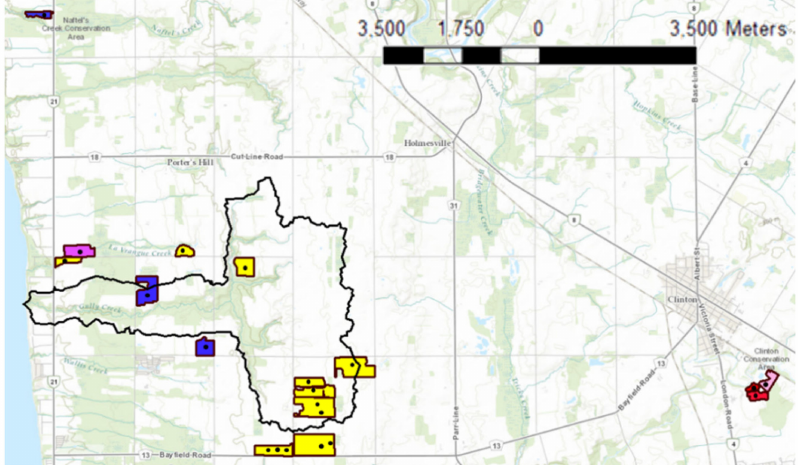
Figure 3. The locations of soil sampling points on the soil map and the soil texture of the fields. Legend: ▬ Gully Creek boundaries, ▬ field sites boundaries, ■ clay loam, ■ loam, ■ silty clay ■ sandy loam, ■ silty clay loam.